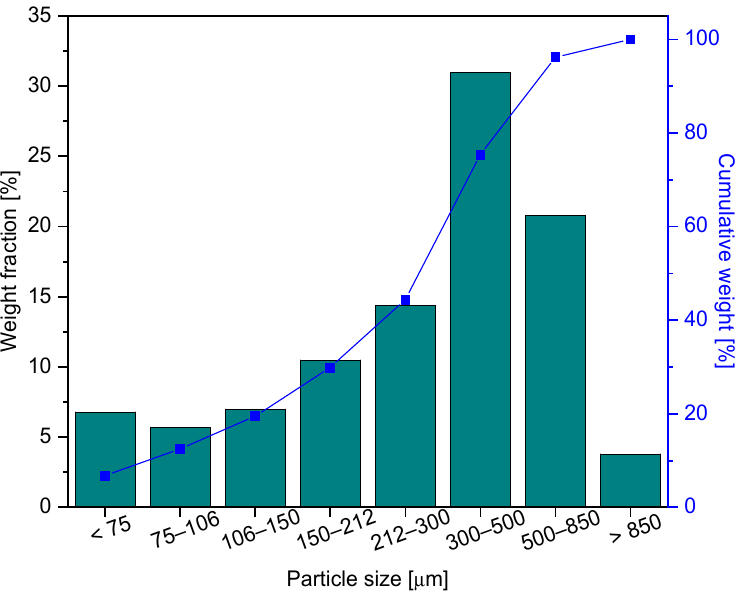
Figure 4. Rice husk particle distribution.